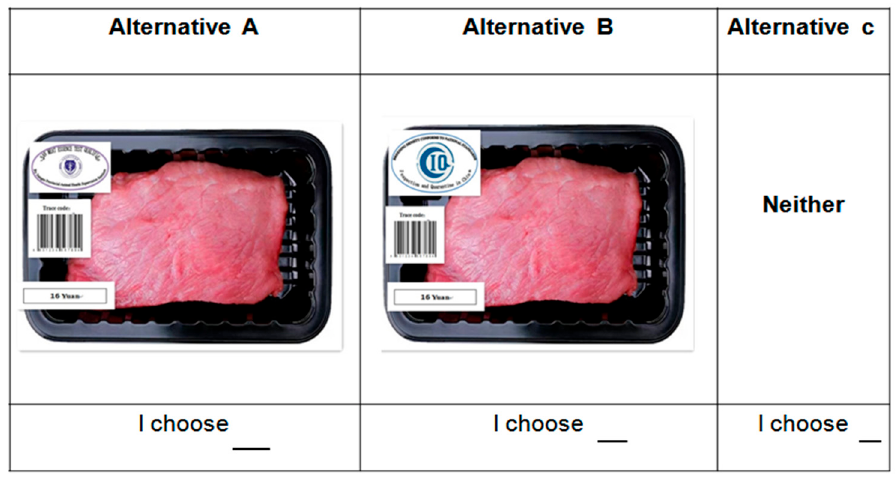
Figure 2. Example of a choice task for a package of 0.5 kg of pork